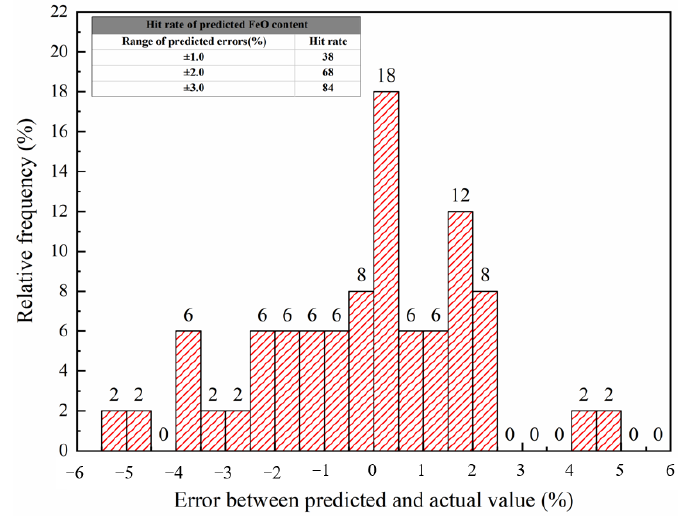
Figure 9. Error distribution of BP neural network predicted model.